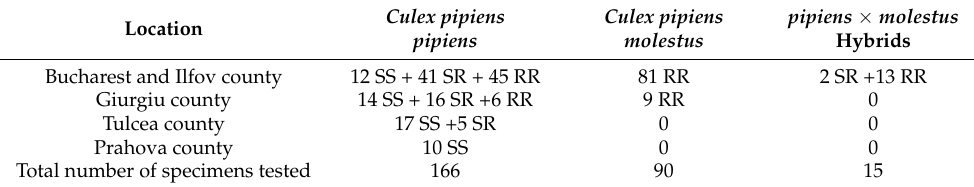
Table 4. Distribution of voltage gated Na + channel (VGSC) L1014F substitution in the mosquito samples analysed.